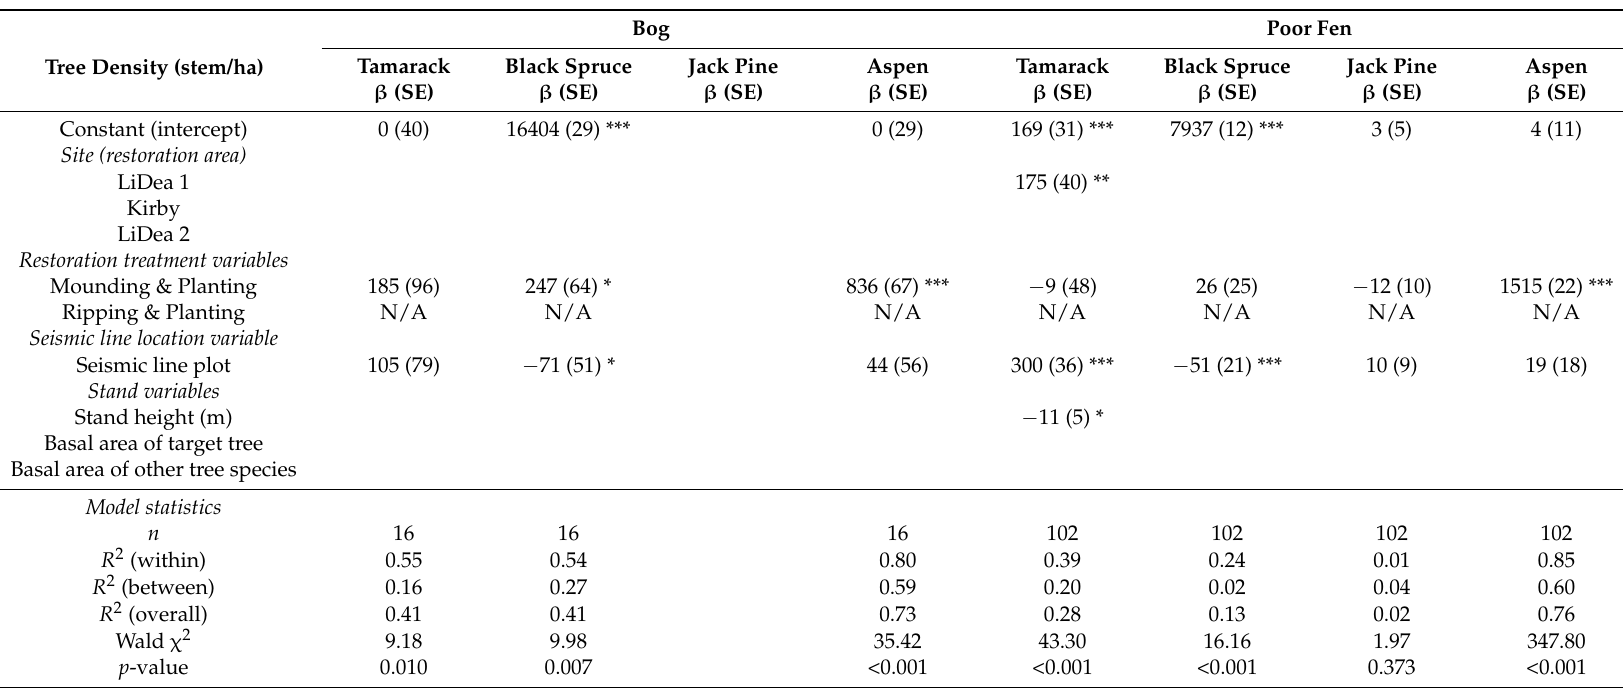
Table A1. Random effect linear model (xtreg) parameters (coefficient, β ; and standard error, SE) relating regeneration density (DBH < 1 cm) (log 10 transformed) of all tree species to all three restoration areas, restoration treatment (mounding & planting or ripping & planting), and seismic line location (vs. adjacent forest control). Both restoration treatment and seismic line location were included regardless of significance. *** p < 0.001, ** p < 0.01, * p <